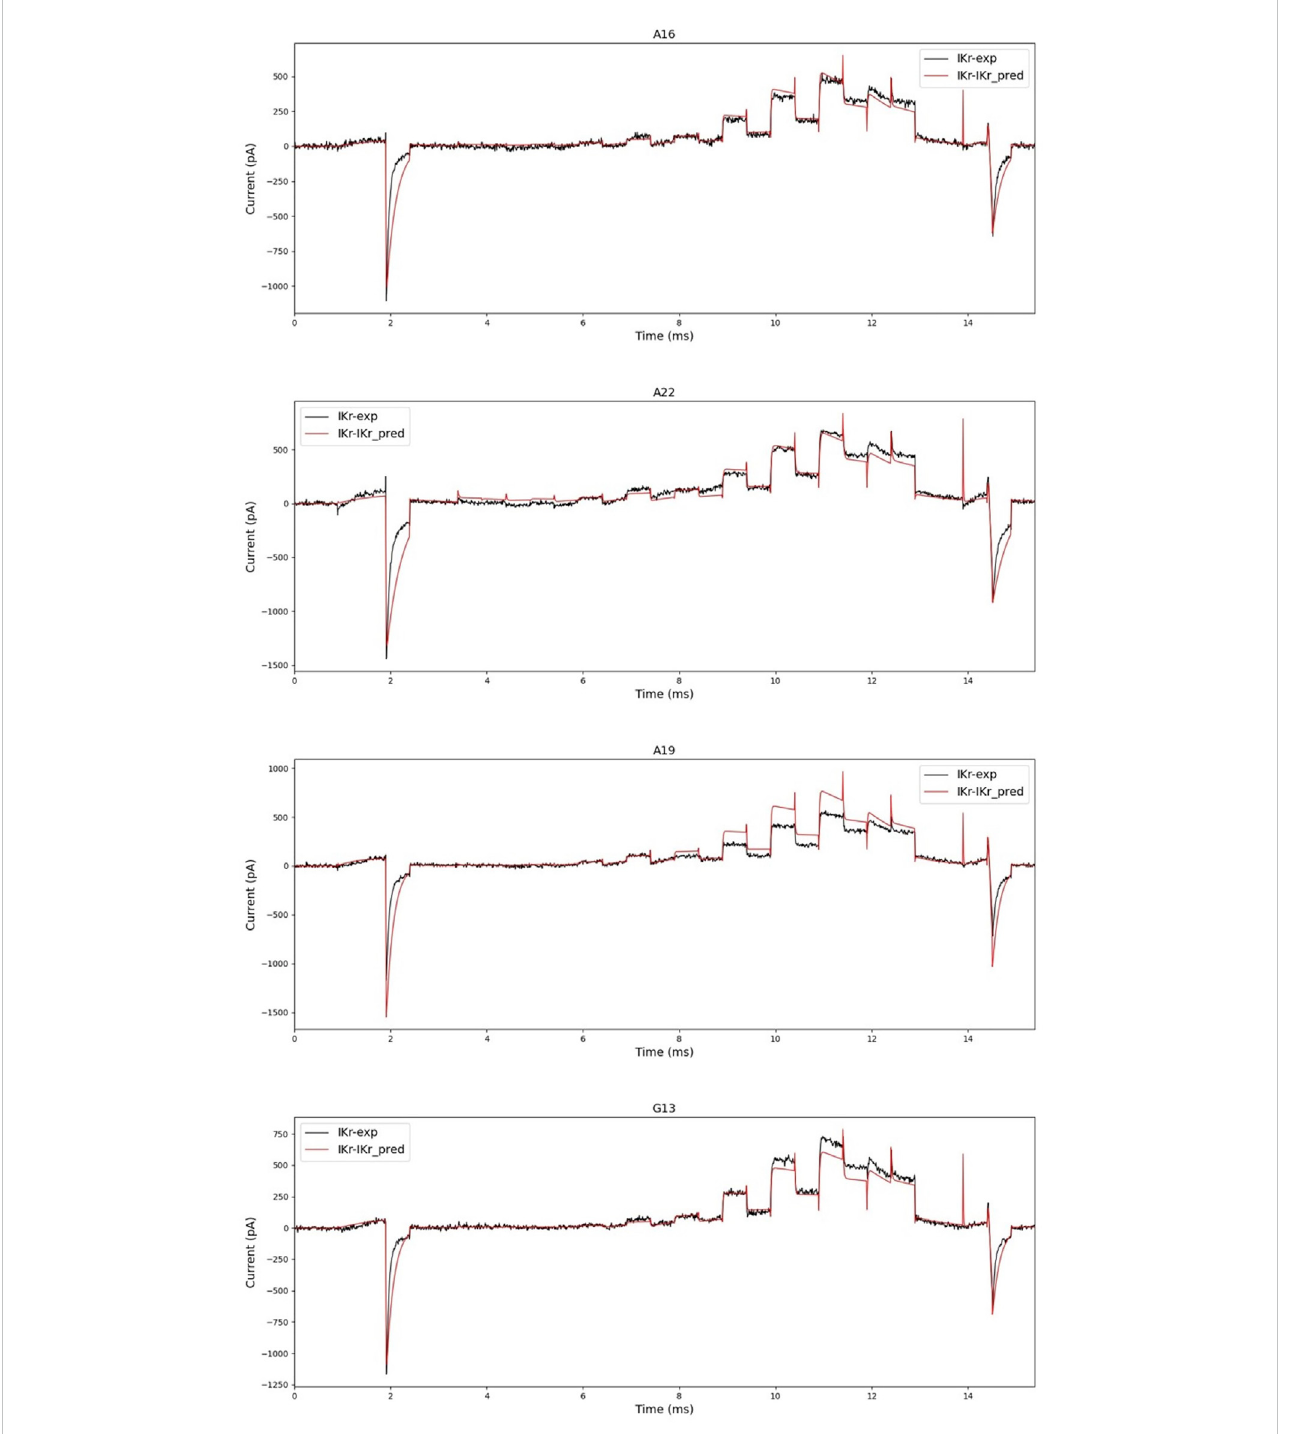
FIGURE 8 Black is experimental data, and red is simulated current data with parameters predicted by hERGNet. There are some very close predictions, such as A16 and A22, and results showing differences, such as A19 and G13. However, the fl ow and shape of the current are somewhat